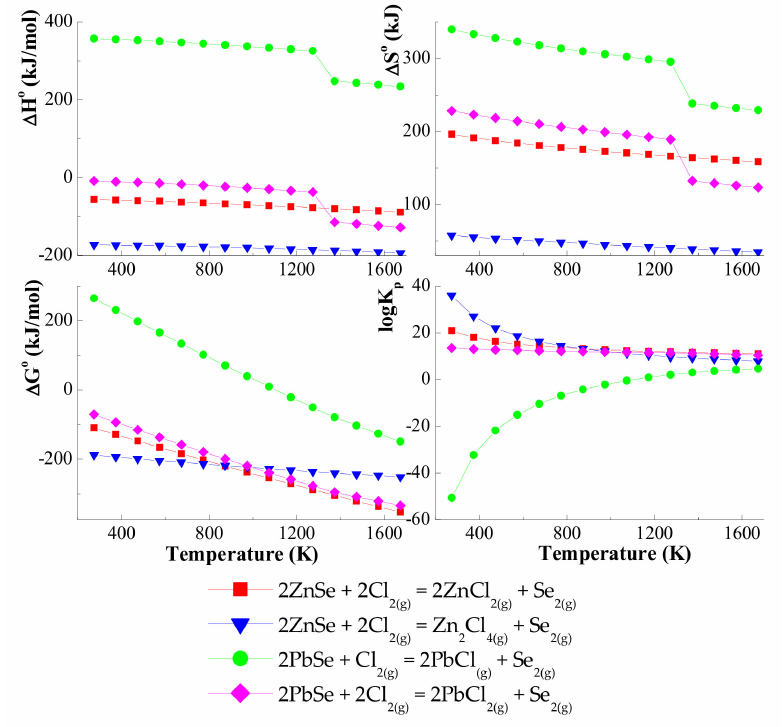
Figure 3. The dependence of the thermodynamic parameters vs. temperature T for the ZnSe and PbSe with Cl 2 as a transport